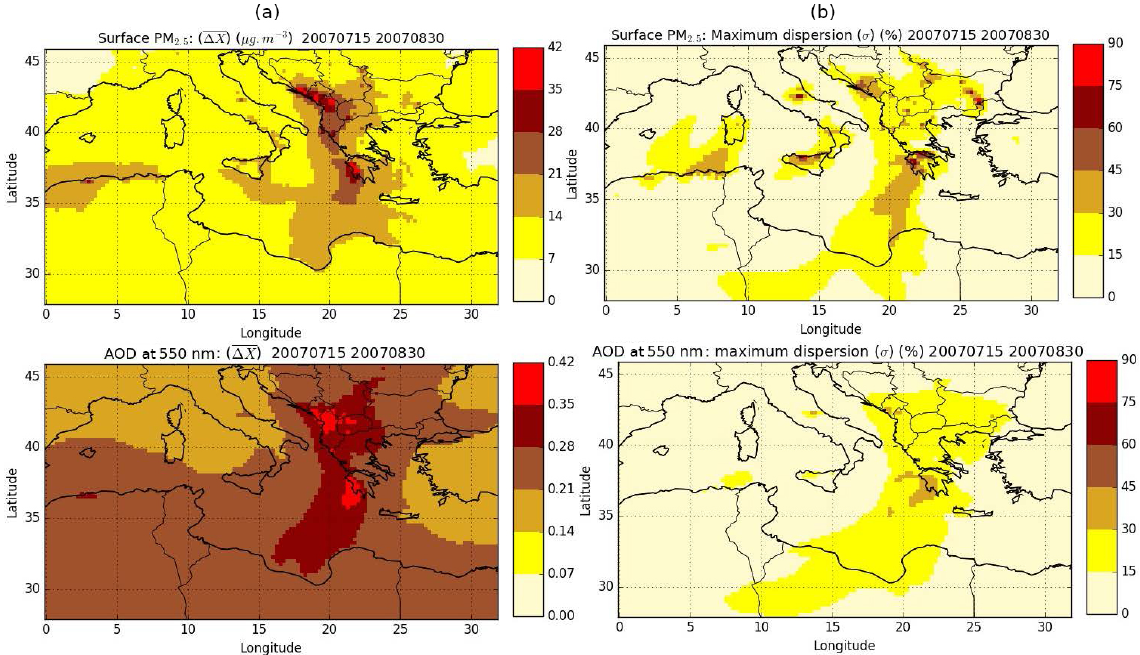
Figure 11. Mean surface PM 2 . 5 concentrations and AOD (estimated using four Polyphemus sensitivity simulations) (a) and their relative maximum statistical dispersion ( σ ) (b) during the summer of